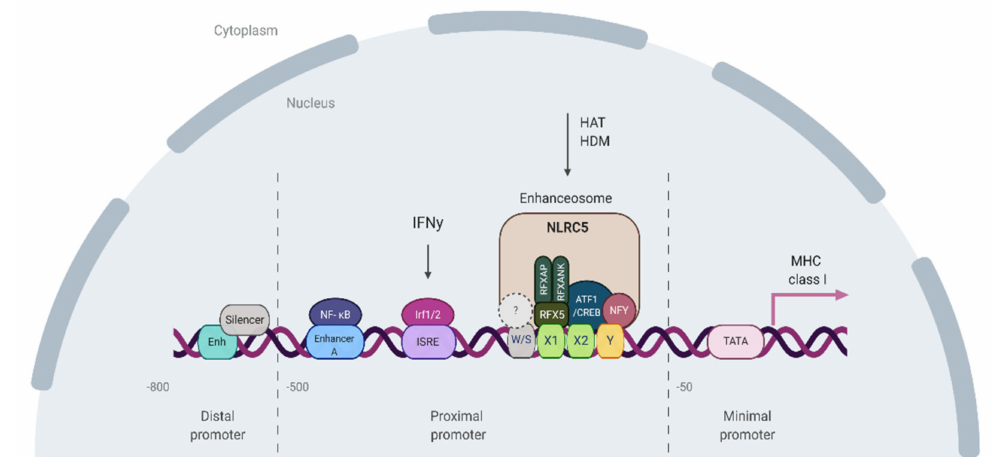
Figure 3. The MHC class I promoter region. Tissue-specific expression of MHC class I is mediated through the regulatory elements located in the distal promoter (overlapping enhancer and silencer located − 800 and − 700 bp upstream to the transcription start site) [112]. The basal transcription level is mediated by the minimal MHC class I core promoter sequence (located from − 50 bp to + 14 bp)